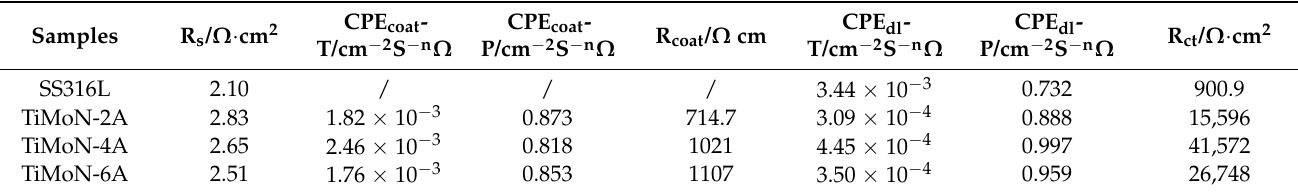
Table 6. EIS fitting consequences of SS316L and